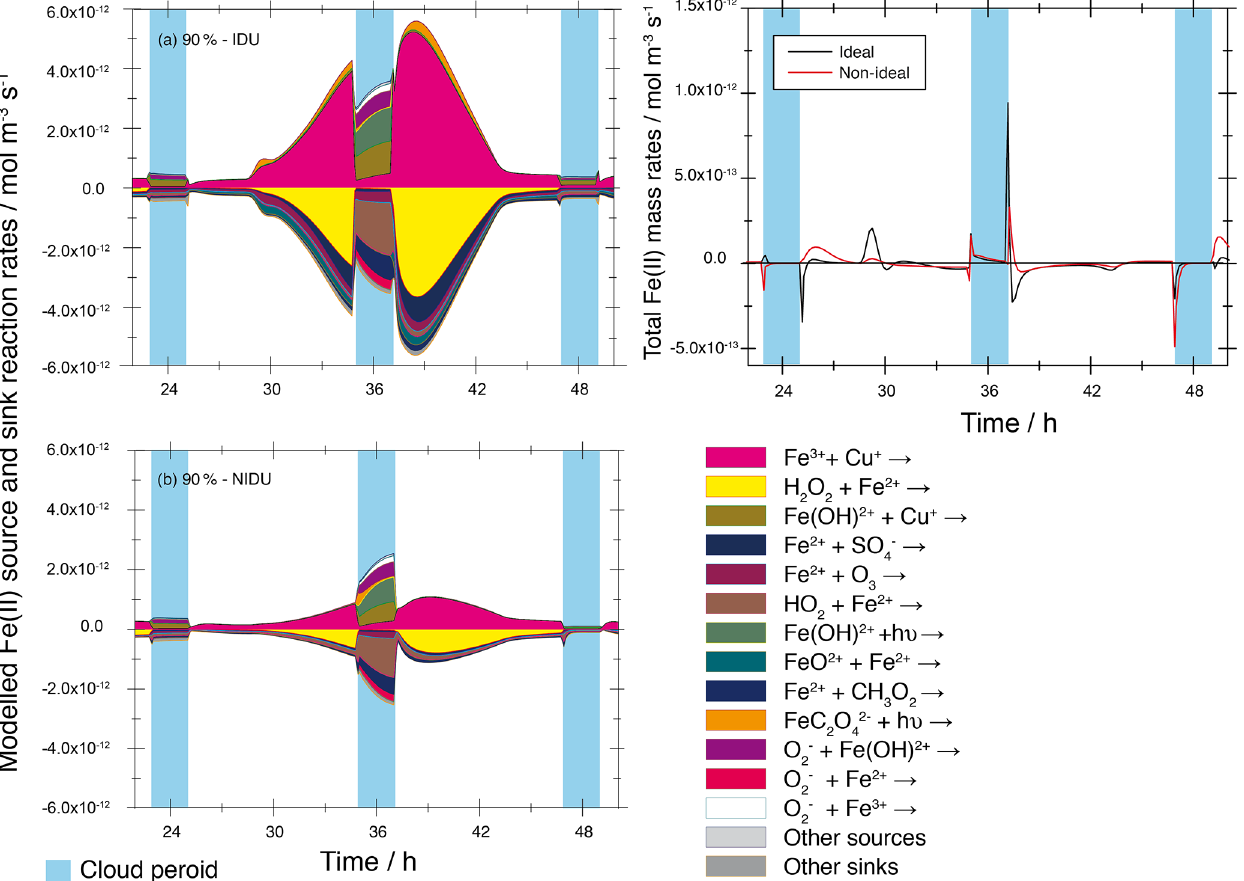
Figure 5. Modelled chemical sink and source mass rates of Fe(II) in the aqueous phase in molm − 3 s − 1 for the second day of the urban cases (90%-IDU / 90%-NIDU). (a) Ideal solutions (90%-IDU), (b) non-ideal solutions (90%-NIDU), and (c) corresponding total rates (sum of source and sink rates). Only sinks and sources with a contribution larger than ± 3% are